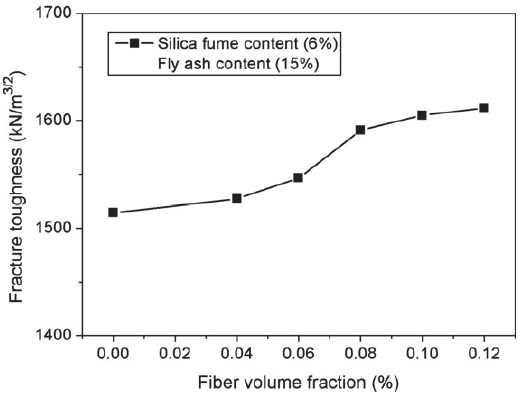
Figure 6 Effect of the polypropylene fiber on fracture toughness.